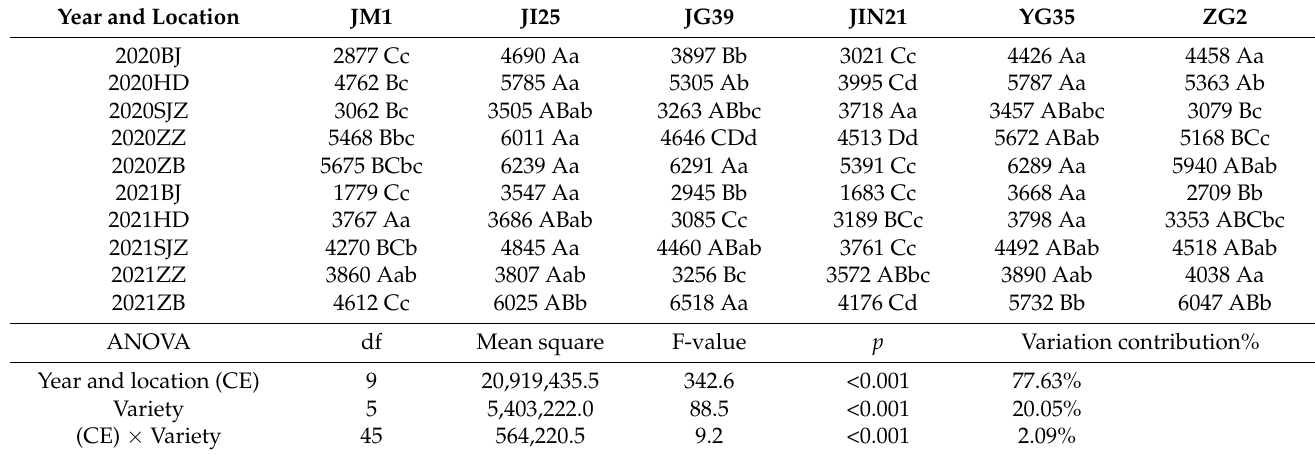
Figure 5. Effects of year and location on yield. Different lowercase and uppercase letters on columns suggest the differences are statistically significant at p < 0.05 and p < 0.001 according to LSD test, respectively. Table 8. ANOVA for yield traits studied along with its contribution toward total variation among 6 varieties of foxtail millet with ten year and location